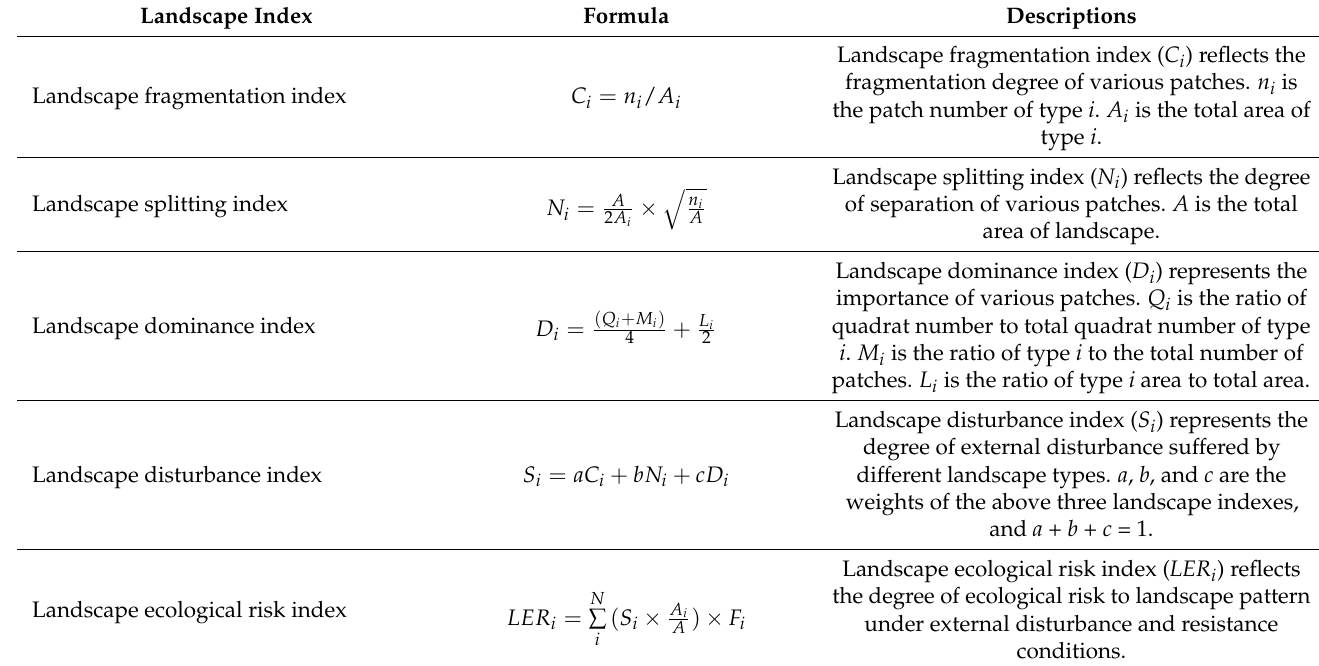
Table A4. Landscape index calculation